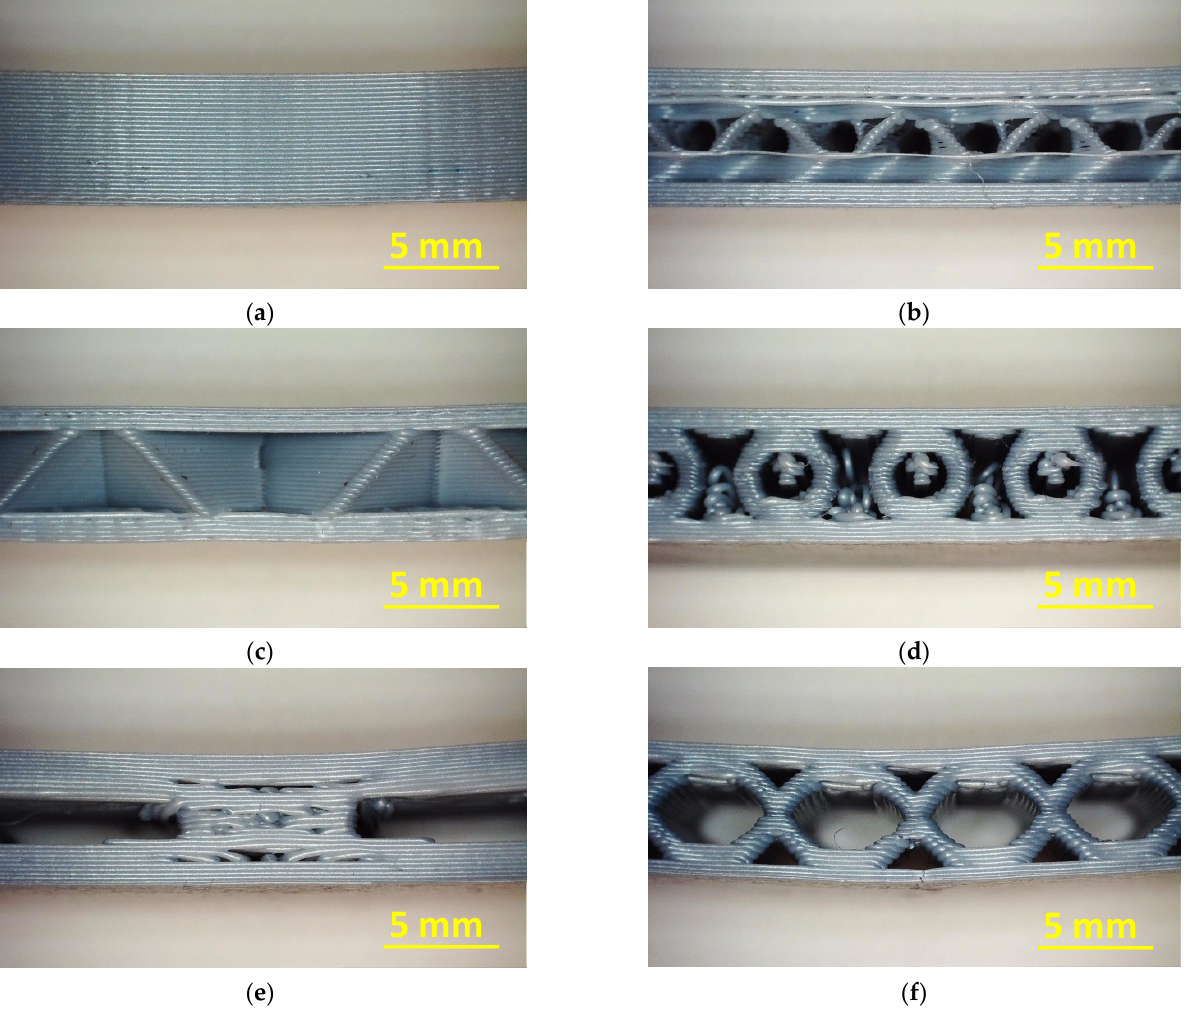
Figure 4. Microscopic images taken after 10 cycles of three-point bending and recovery tests of samples with different infill patterns: ( a ) LN100; ( b ) GY15; ( c ) OC15; ( d ) ZHR100; ( e ) LP100; and ( f )